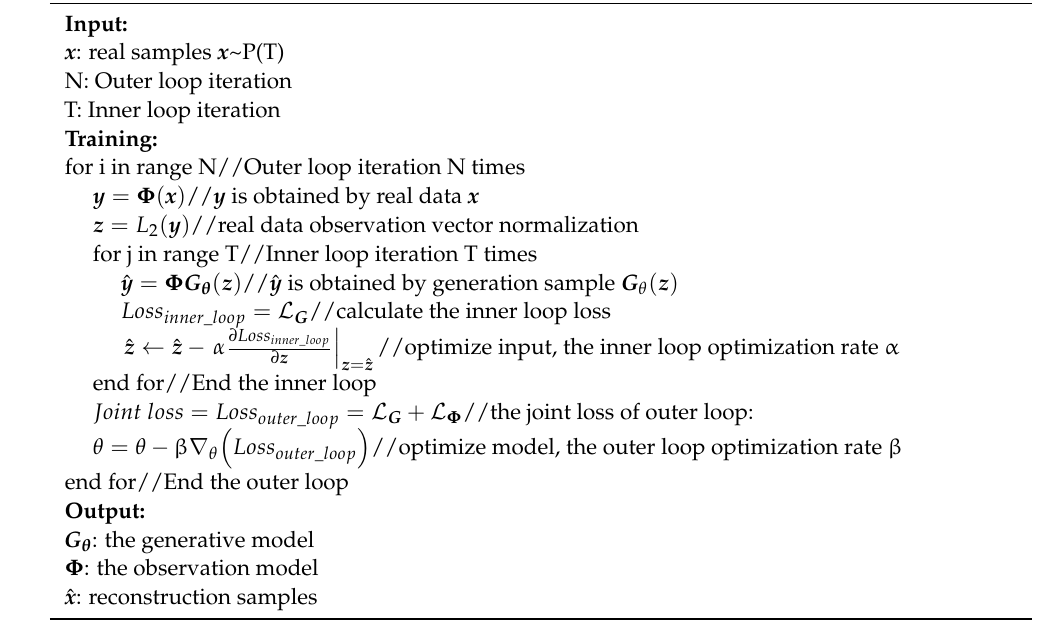
Algorithm 1: The pseudo code of end-to-end deep compressed sensing generative model